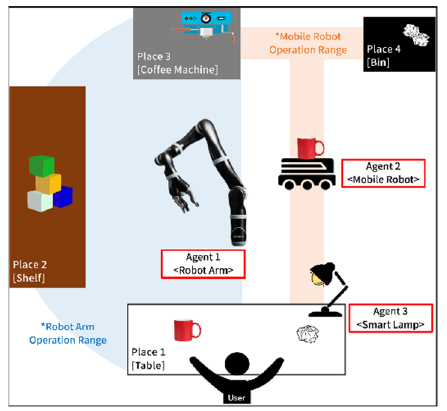
Figure 2. VR smart office setting.